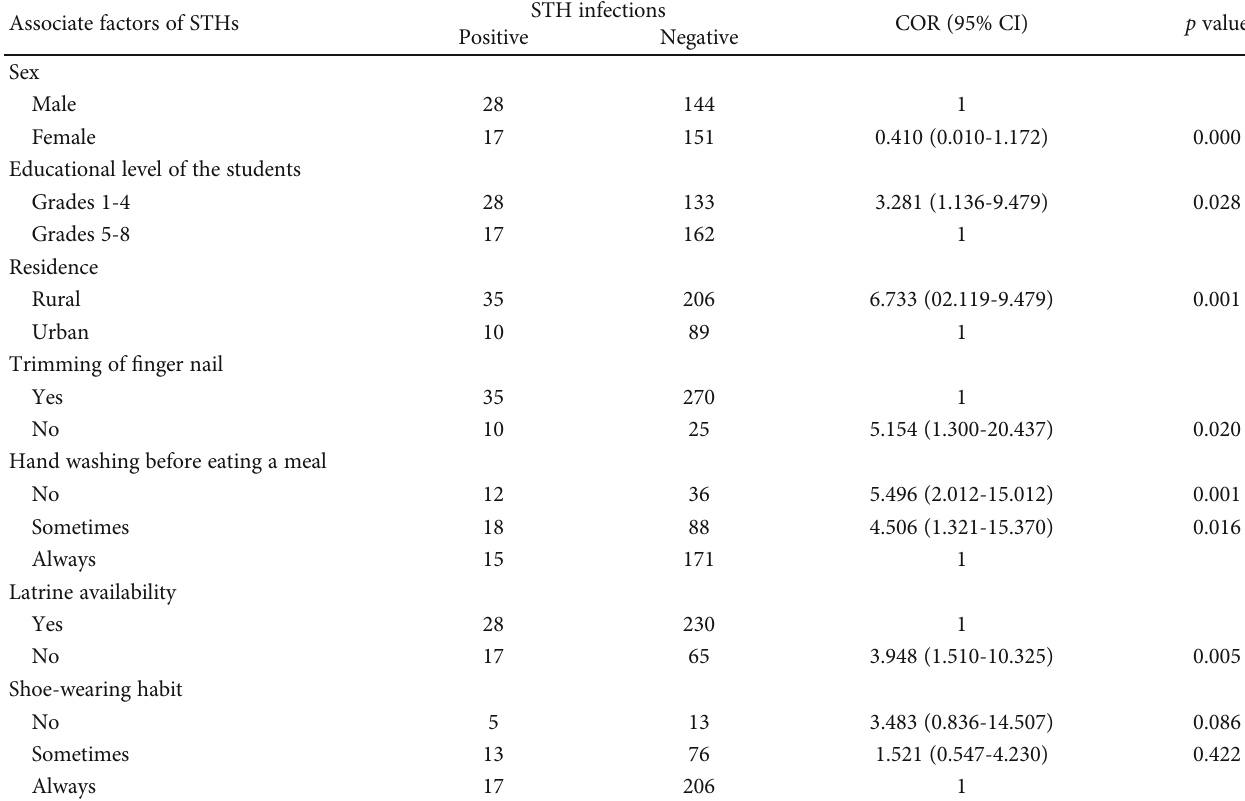
Table 4: Multivariate analysis of association factors of STH infection among Hiruy Abaregawi primary school children from March to April, 2019, Debre Tabor town, North West